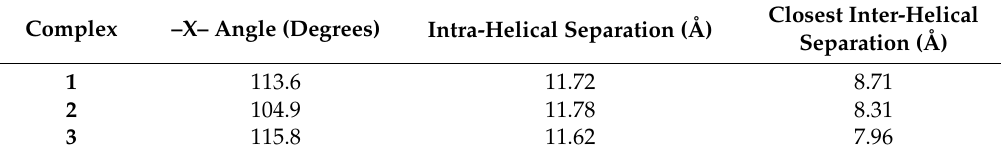
Table 2. Comparison of helical geometric parameters in 1 , 2 and 3 .